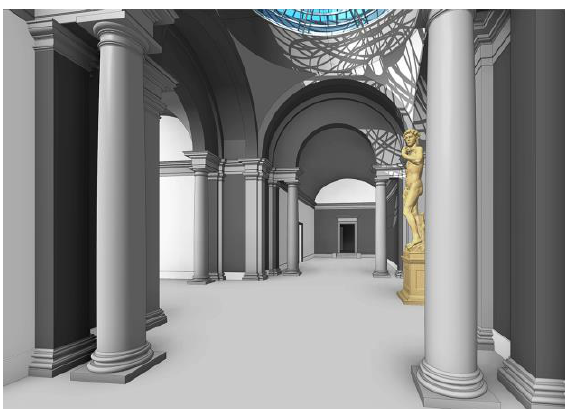
Figure 8. Michelangelo’s David in